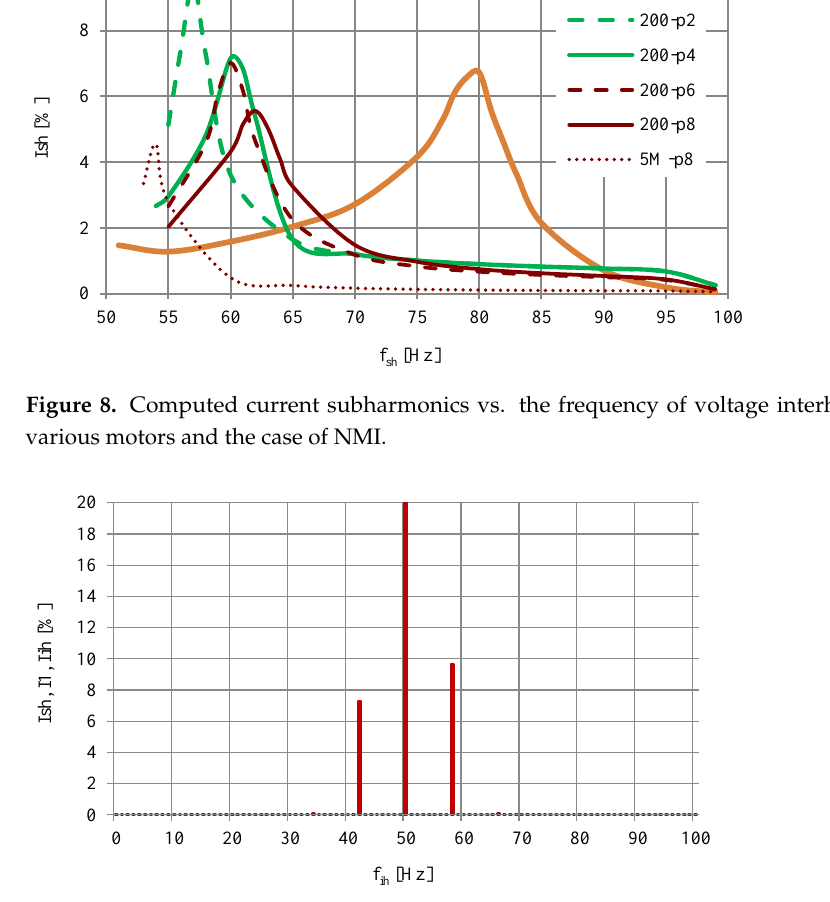
Figure 9. Computed current spectrum of motor 200-p2, supplied with voltage containing interhar- monics of frequency f ih = 58 Hz for the case of NMI.